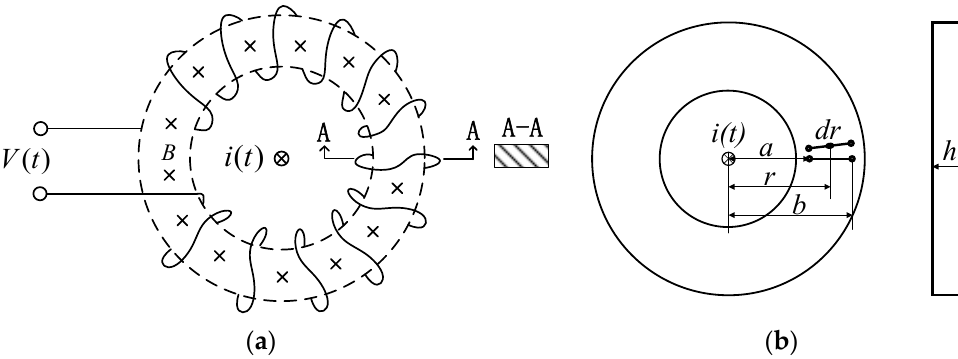
Figure 1. Principle of a Rogowski Coil. ( a ) Structure Diagram of traditional Rogowski coil; ( b ) Structure Diagram of PCB Rogowski coil.